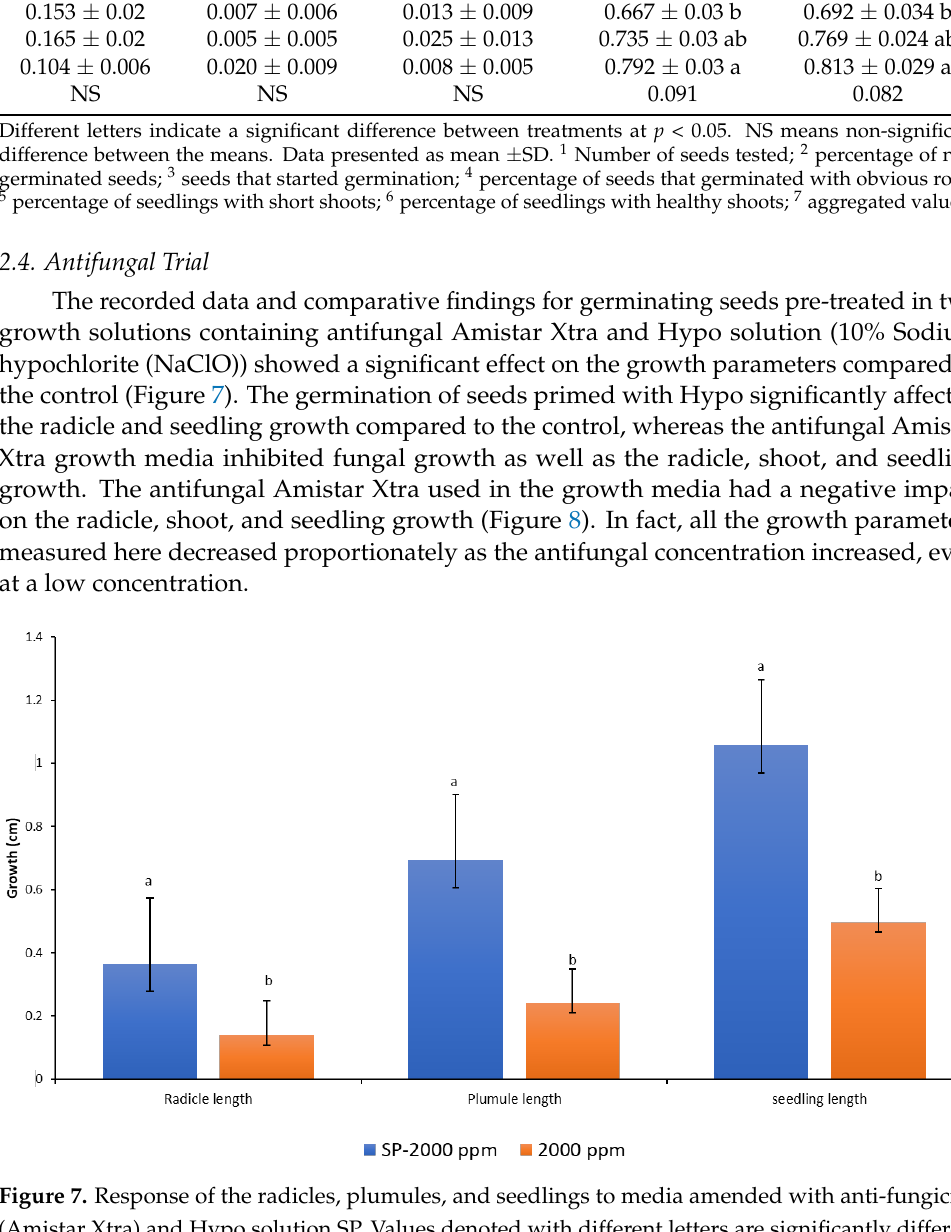
Figure 8. Response of radicles, plumules, and seedlings to different concentrations of antifungal. Values denoted with different letters are significantly different at p < 0.05. The techniques of seed priming with fungi sterilizer solution and growing of seeds in growth media containing the fungicide Amistar Xtra were compared in this experiment (Figure 9). The priming technique showed a significantly more positive effect on all the growth parameters than the amendment of seeds in the growth media. Seed pre-treatment or priming can offer a viable alternative for the prevention of fungal growth during seed germination in vitro.